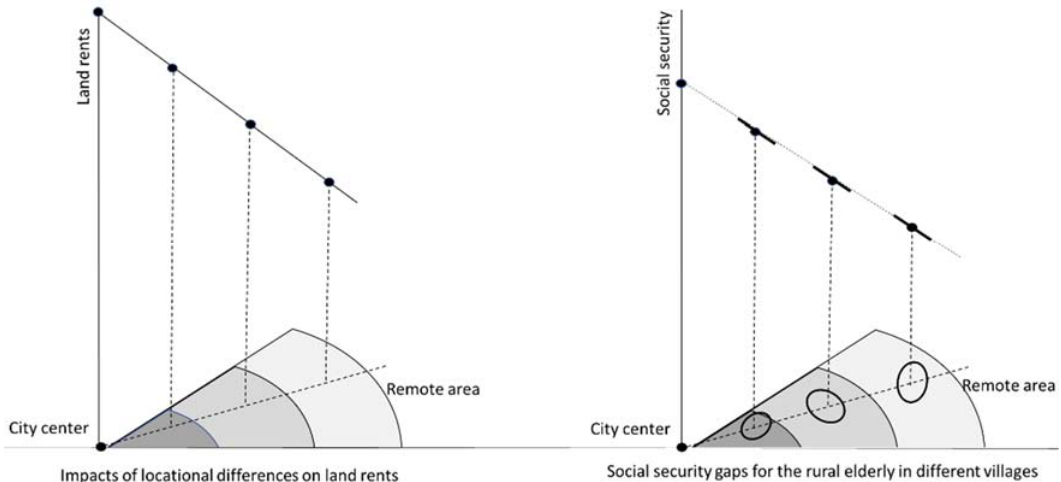
Figure 5. Impacts of locational differences on land rents and social security gaps.